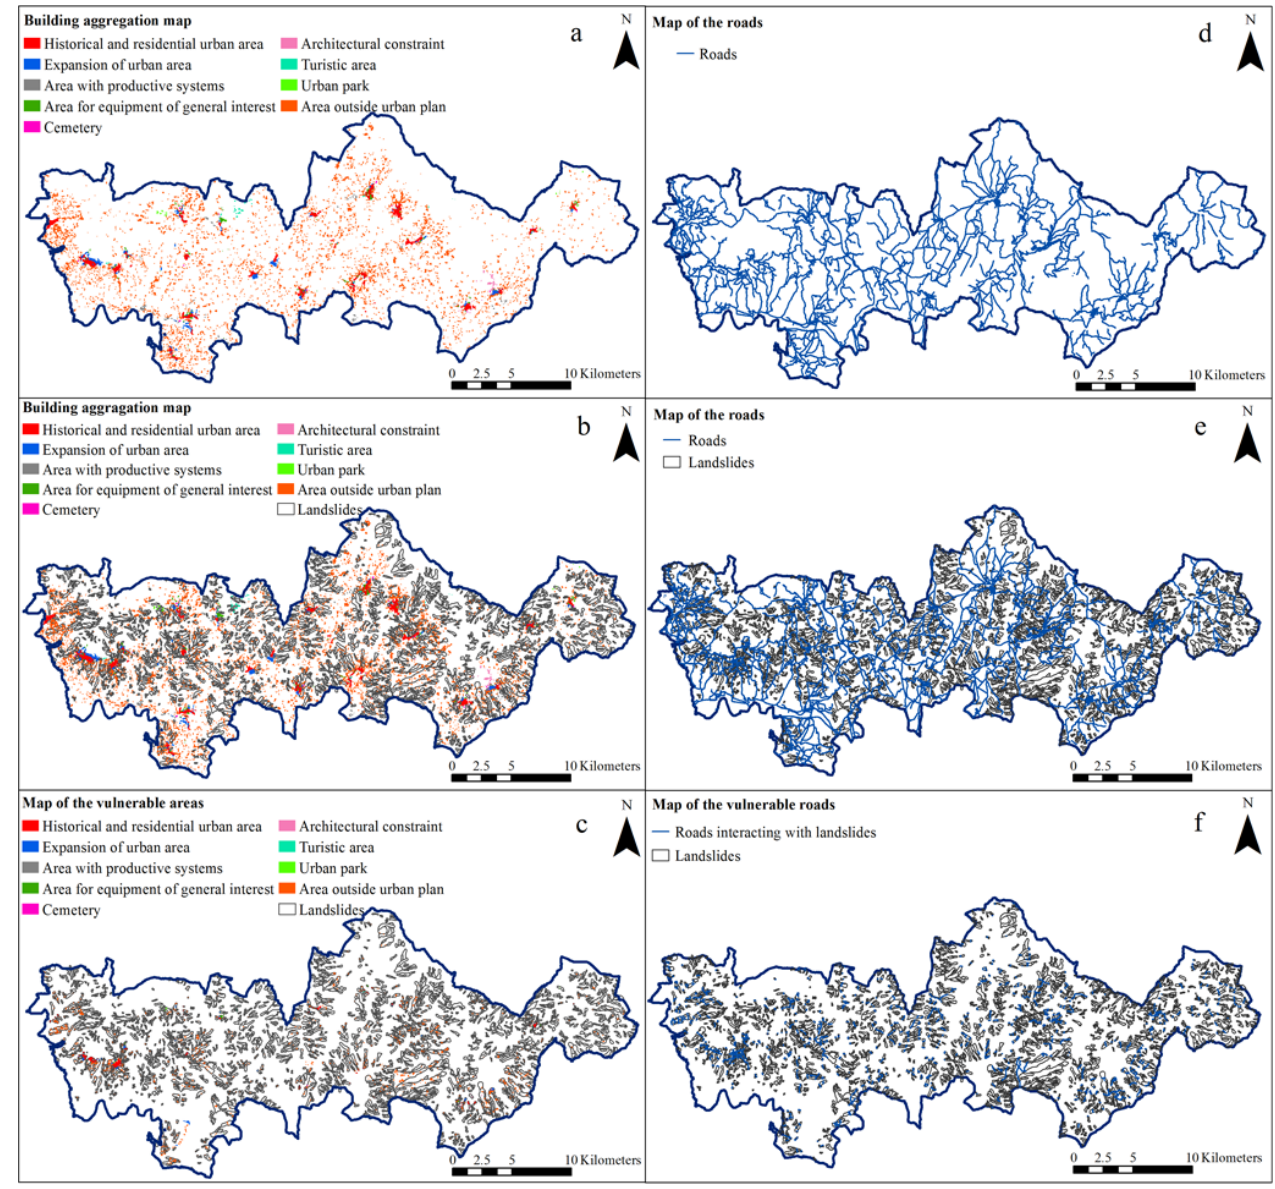
Fig. 17. (a) Building aggregation map; (b) map of building aggregations and landslides; (c) map of vulnerable areas; (d) map of the roads; (e) map of the roads and landslides; (f) map of the vulnerable